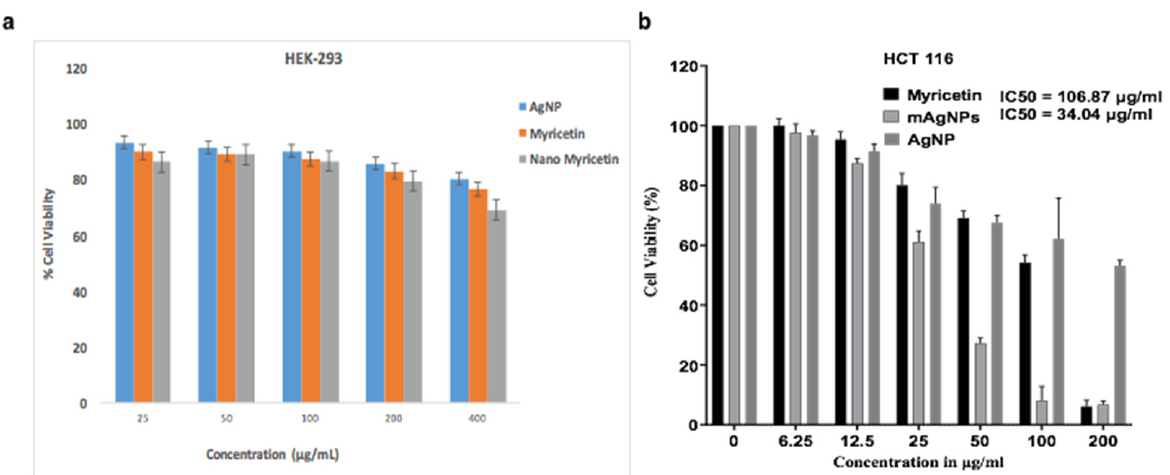
Figure 5. MTT assay (anti-CRC activity). MTT assay was performed to investigate the ( a ) effect of pure myricetin, AgNPs, and mAgNPs (myricetin labeled with AgNPs) in normal cell line HEK293 and ( b ) the anti-CRC activity of pure myricetin, AgNPs, and mAgNPs AgNPs for CRC cell line HCT-116.